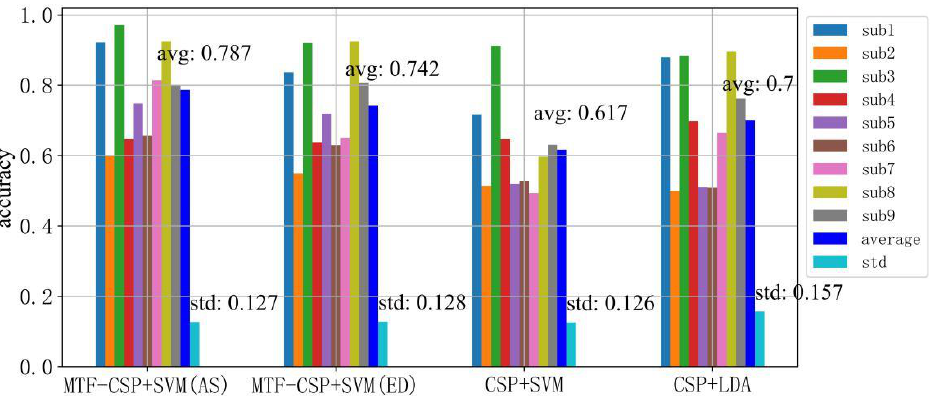
Figure 11. Comparison of classification accuracies of the proposed MTF-CSP based models with the traditional CSP-based models.